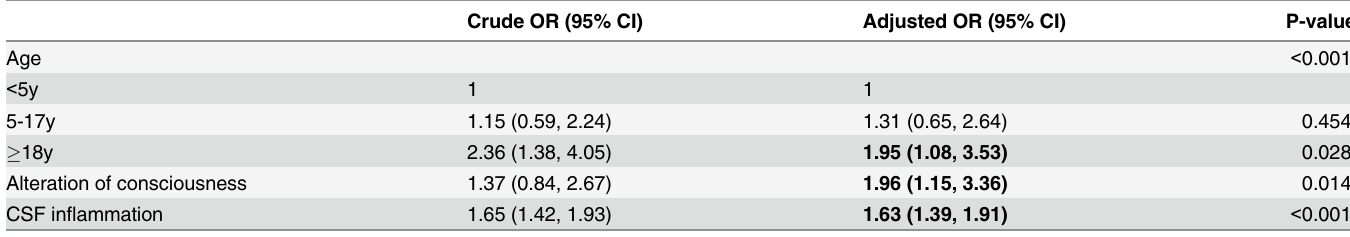
Table 7. Final logistic regression model by using factor scores *